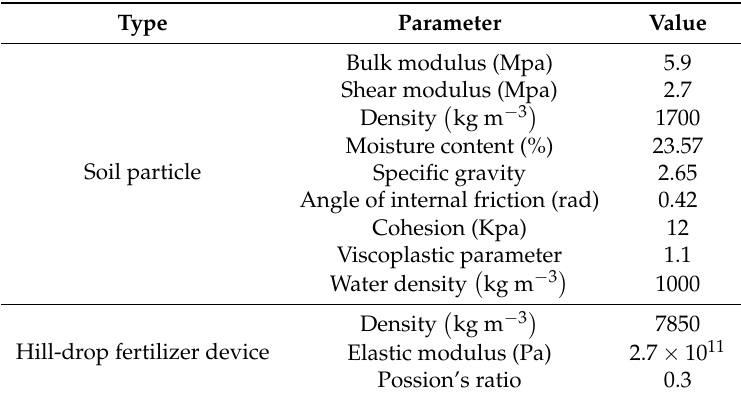
Table 1. Model parameter of soil particle and hill-drop fertilizer